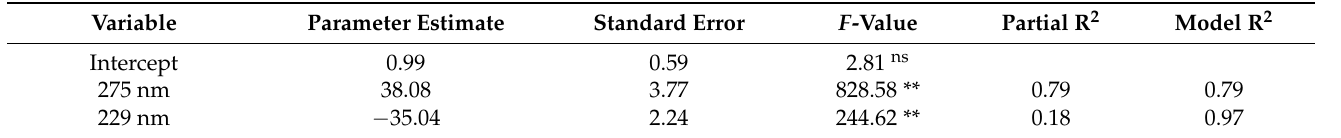
Table 6. Results of stepwise regression between zingiberene content as determined by GC-FID and absorbance values from 200 to 350 nm for the BC5F1 generation.